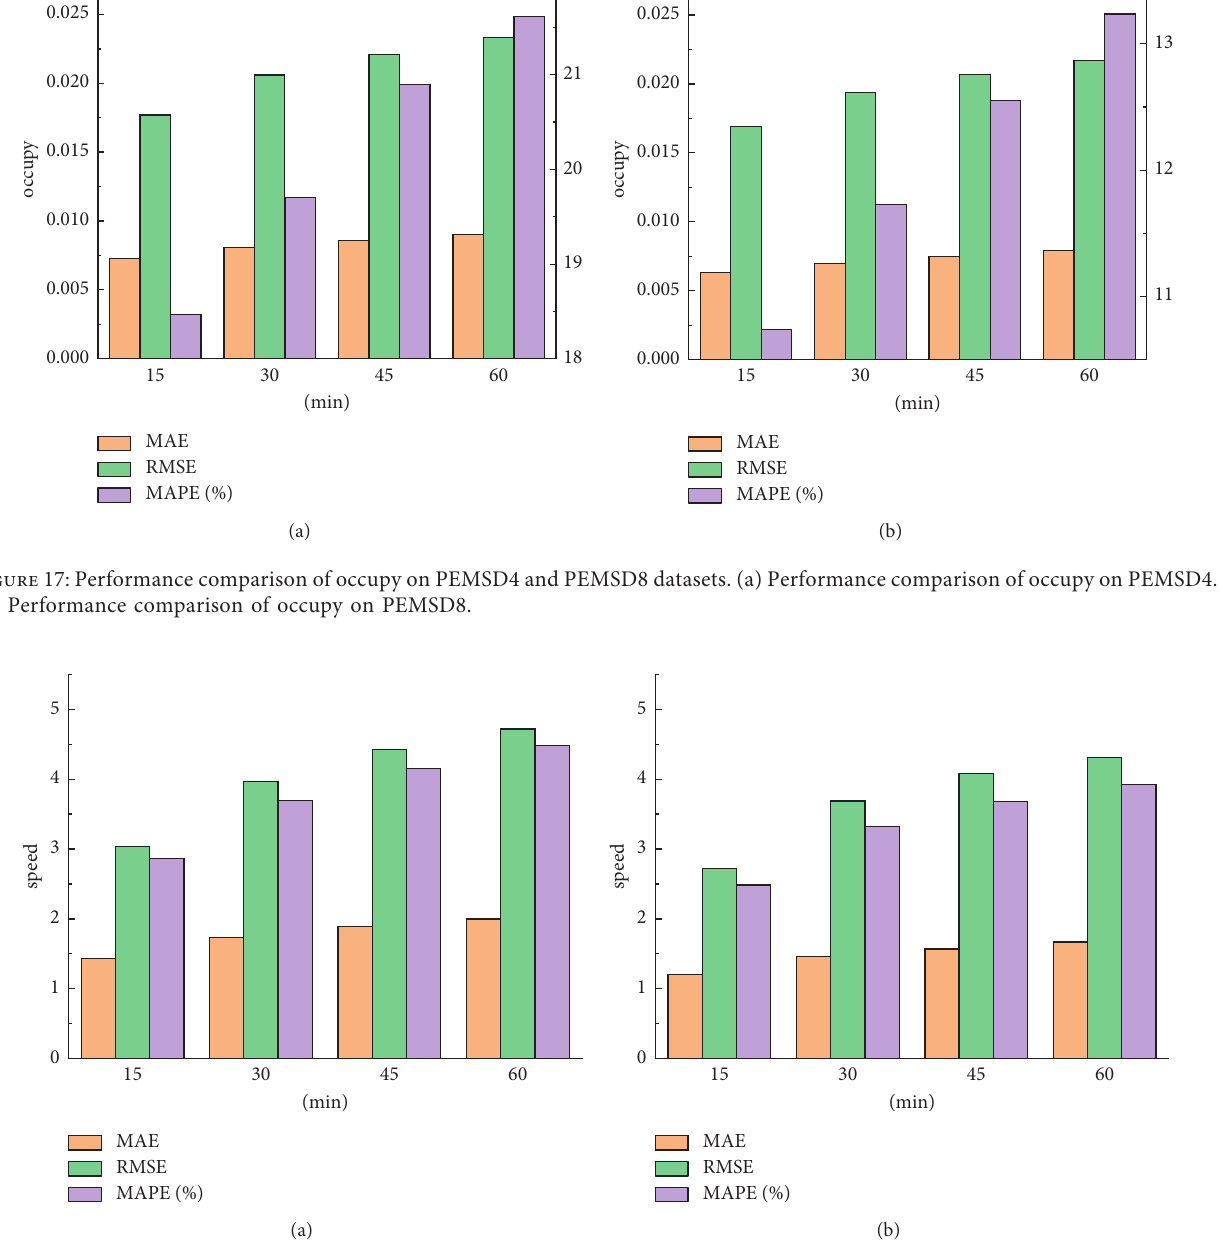
Figure 18: Performance comparison of speed on PEMSD4 and PEMSD8 datasets. (a) Performance comparison of speed on PEMSD4. (b) Performance comparison of speed on